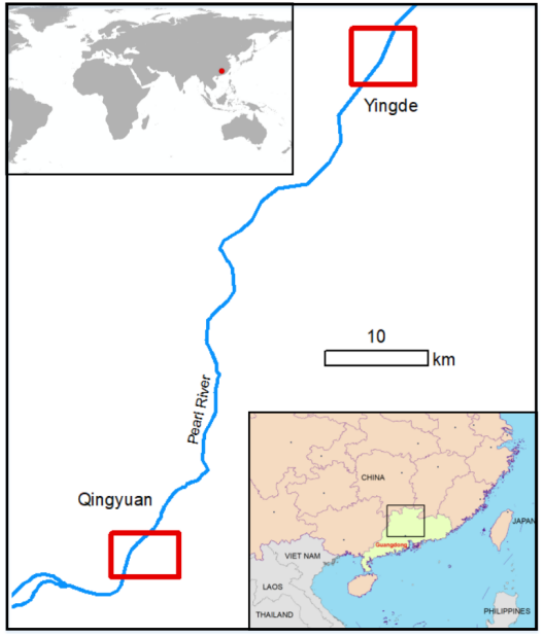
Figure 1 The location of Pearl River in